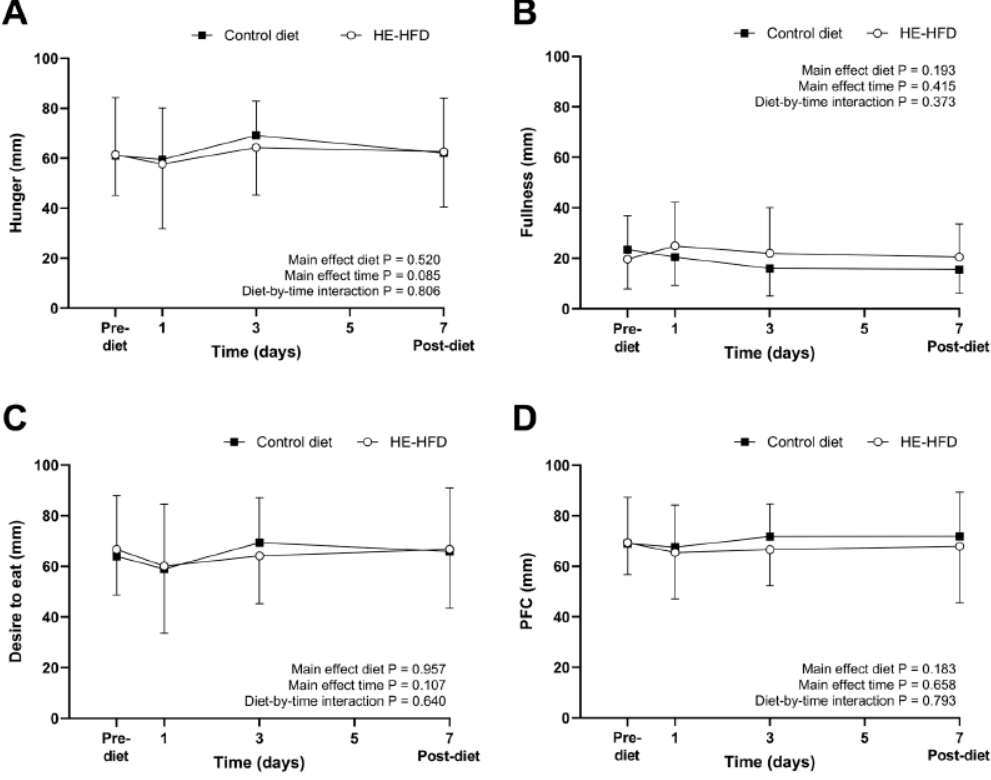
Figure 2. Fasted ratings of perceived ( A ) hunger, ( B ) fullness, ( C ) desire to eat, and ( D ) prospective food consumption (PFC) during the seven-day control diet and hyperenergetic high-fat diet (HE-HFD) in 12 healthy men. Values are mean (SD).